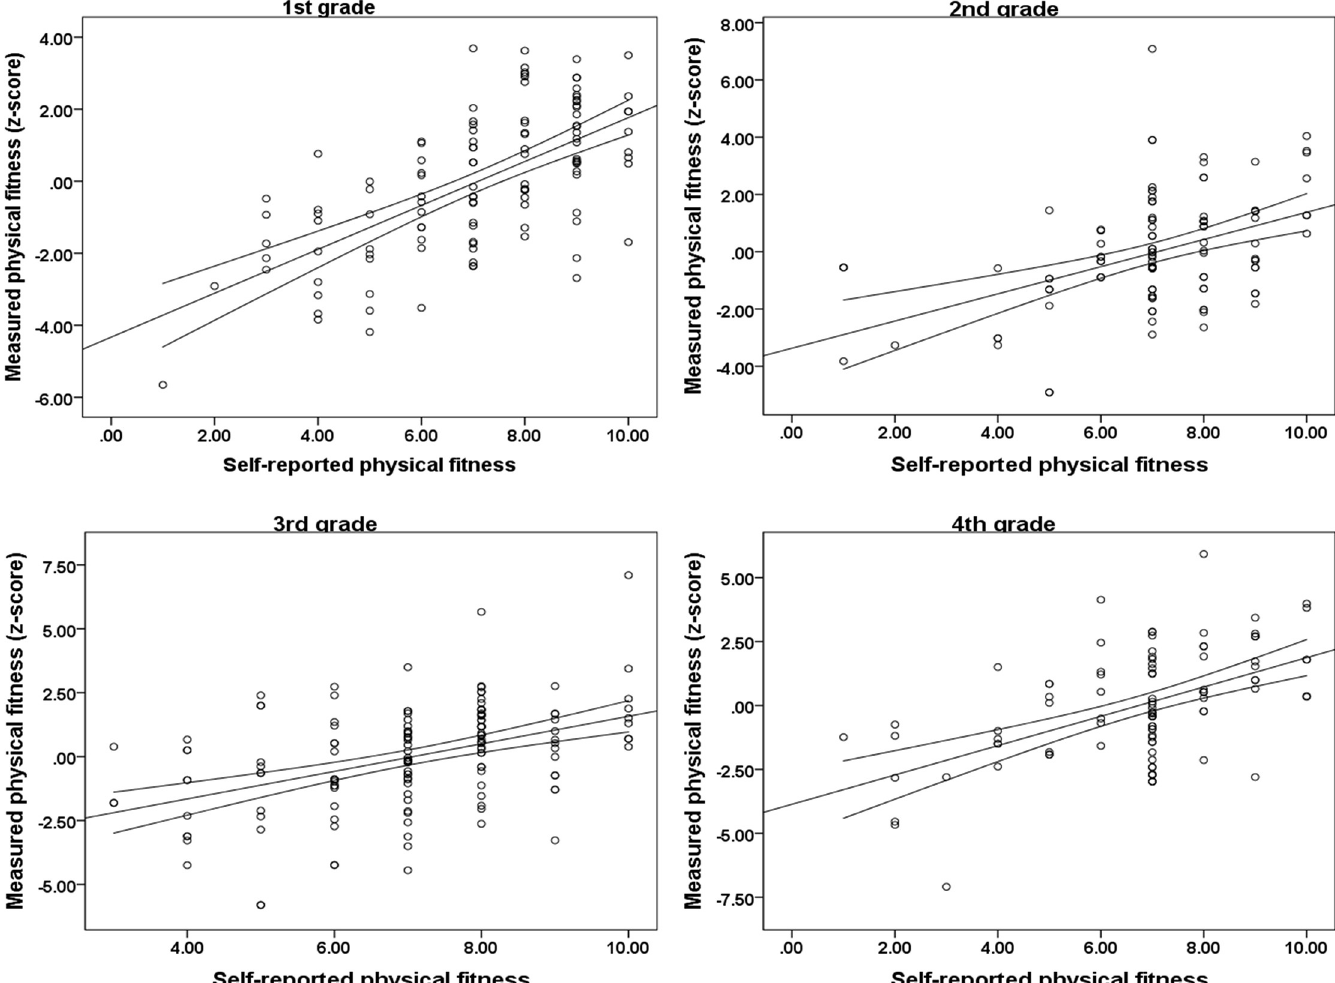
Fig 1. Age specific correlations between self-reported (x-axis) and measured (y-axis) physical fitness in boys (Croatia, 2019).